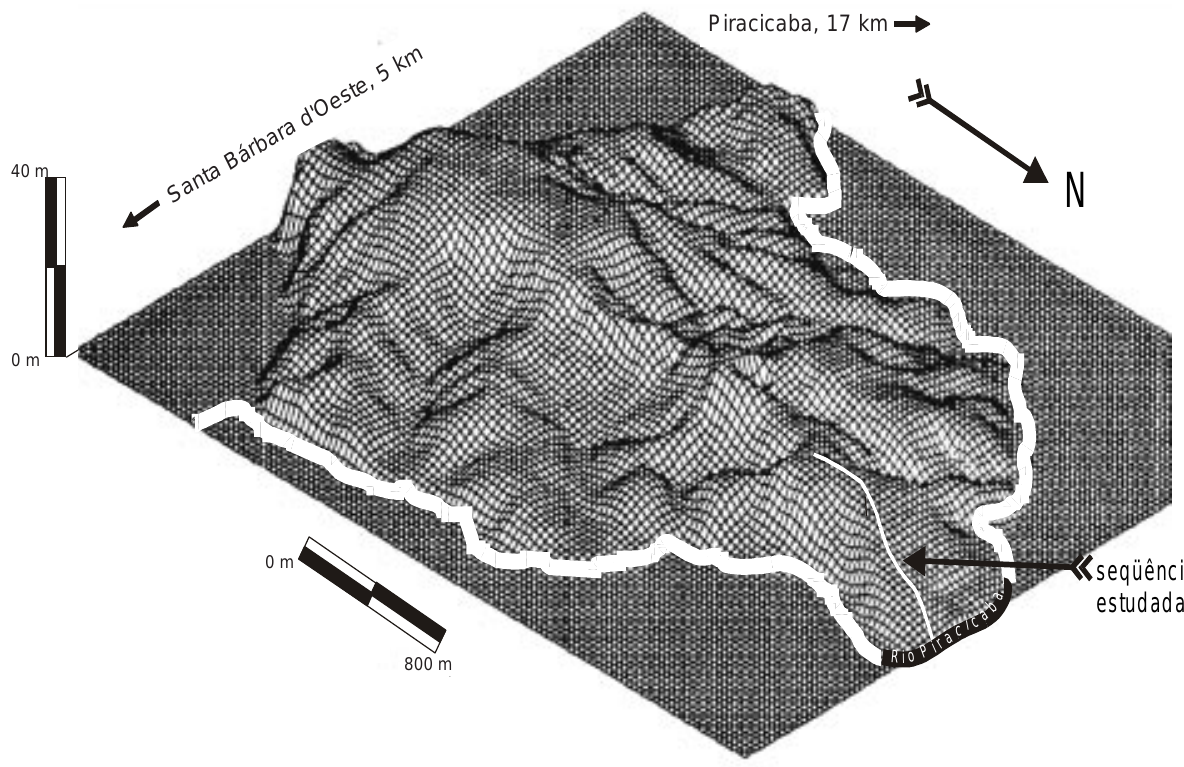
Figura 1. Bloco diagrama geral da área com localização da seqüência estudada. A escala vertical foi exagerada para melhor visualização das formas do relevo que é suavemente ondulado a